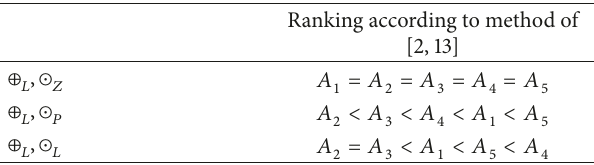
Table 6: Ranking of